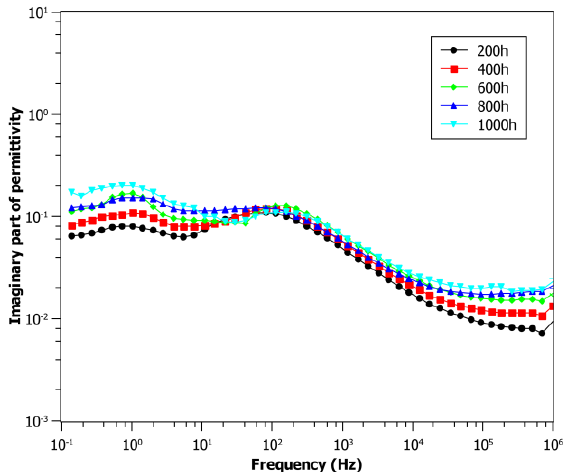
Figure 5. Dielectric spectra of imaginary part of permittivity at different aging times at dose rate 0.42 kGy/h and 55 °C. Tests made at after 5 years of storage.